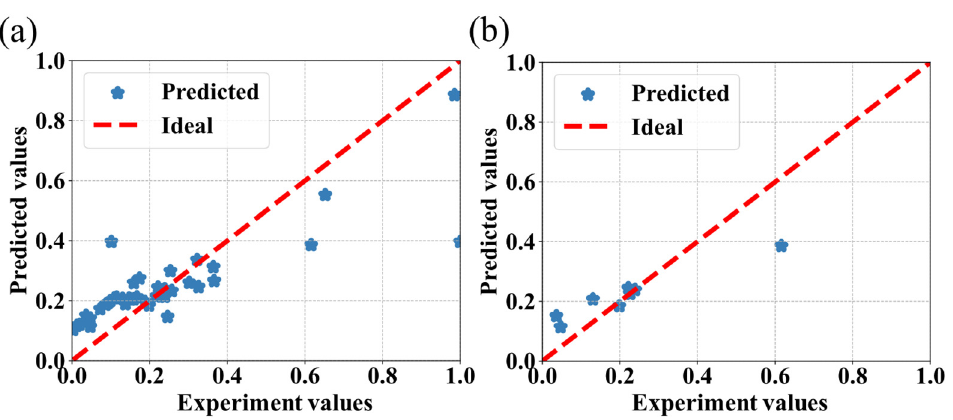
Figure 5. Performance of the SVR algorithm for the prediction of the IBU loading capacity of MOFs associated with the experimental values. ( a ) The predictions are calculated on the entire dataset. ( b ) The predictions are exclusively calculated on the testing dataset.